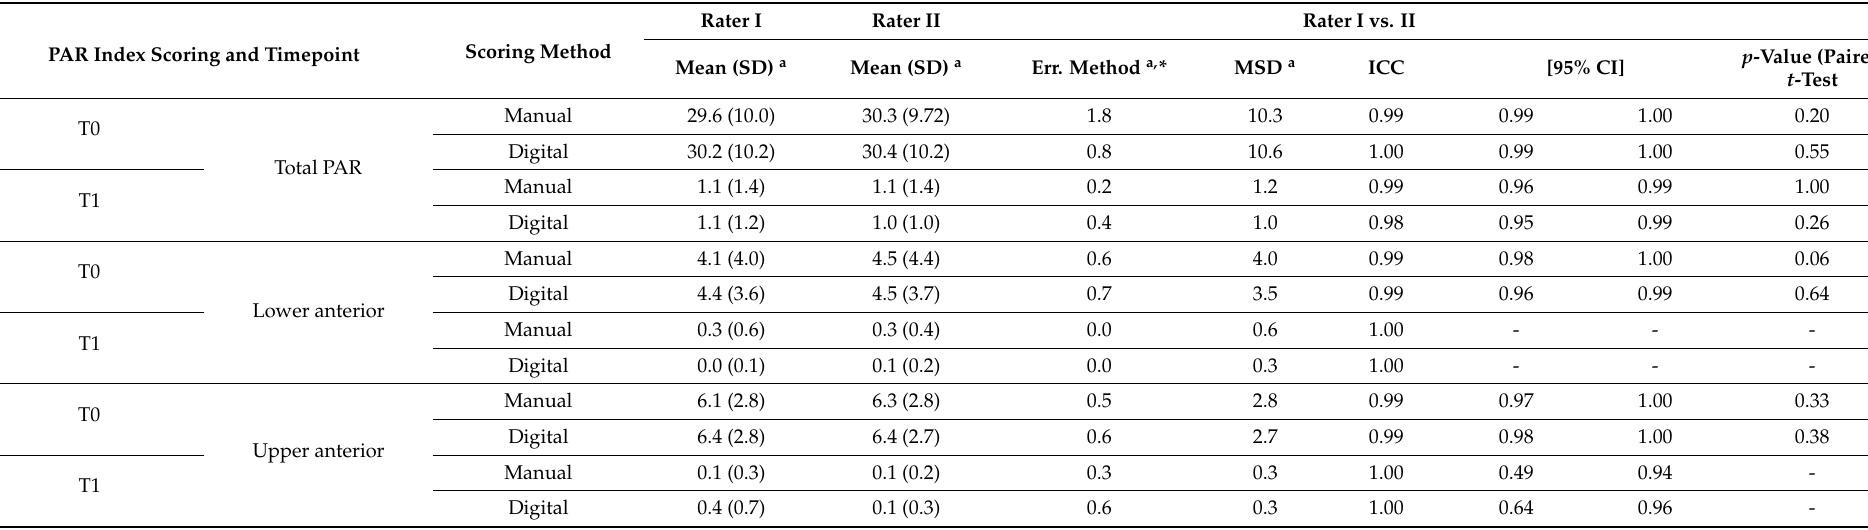
Table 3. Inter-rater variability (error of the method and Minimum Standard Deviation (MSD)) (using the second measurements) and reproducibility (ICC) according to time point and method. Paired sample t -tests comparing both